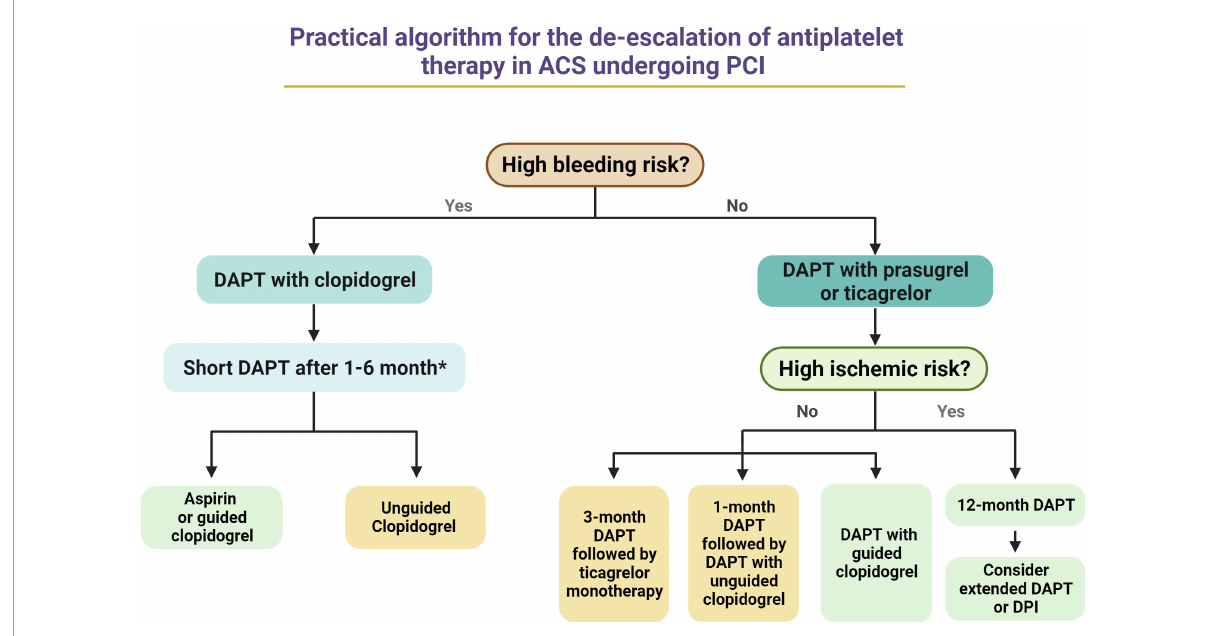
FIGURE4 Practical algorithm for the de-escalation of antiplatelet therapy in ACS undergoing PCI. ∗ Among HBR patients, DAPT duration may range from 1 month (i.e., low ischemic risk NSTEMI patients) to 6 months (i.e., high ischemic risk STEMI patients). Green Box, first choice. Yellow Box, second choice. ACS, acute coronary syndrome; DAPT, dual antiplatelet therapy; PCI, percutaneous coronary intervention; STEMI, ST-segment elevation myocardial infarction; NSTEMI, non-ST elevation myocardial